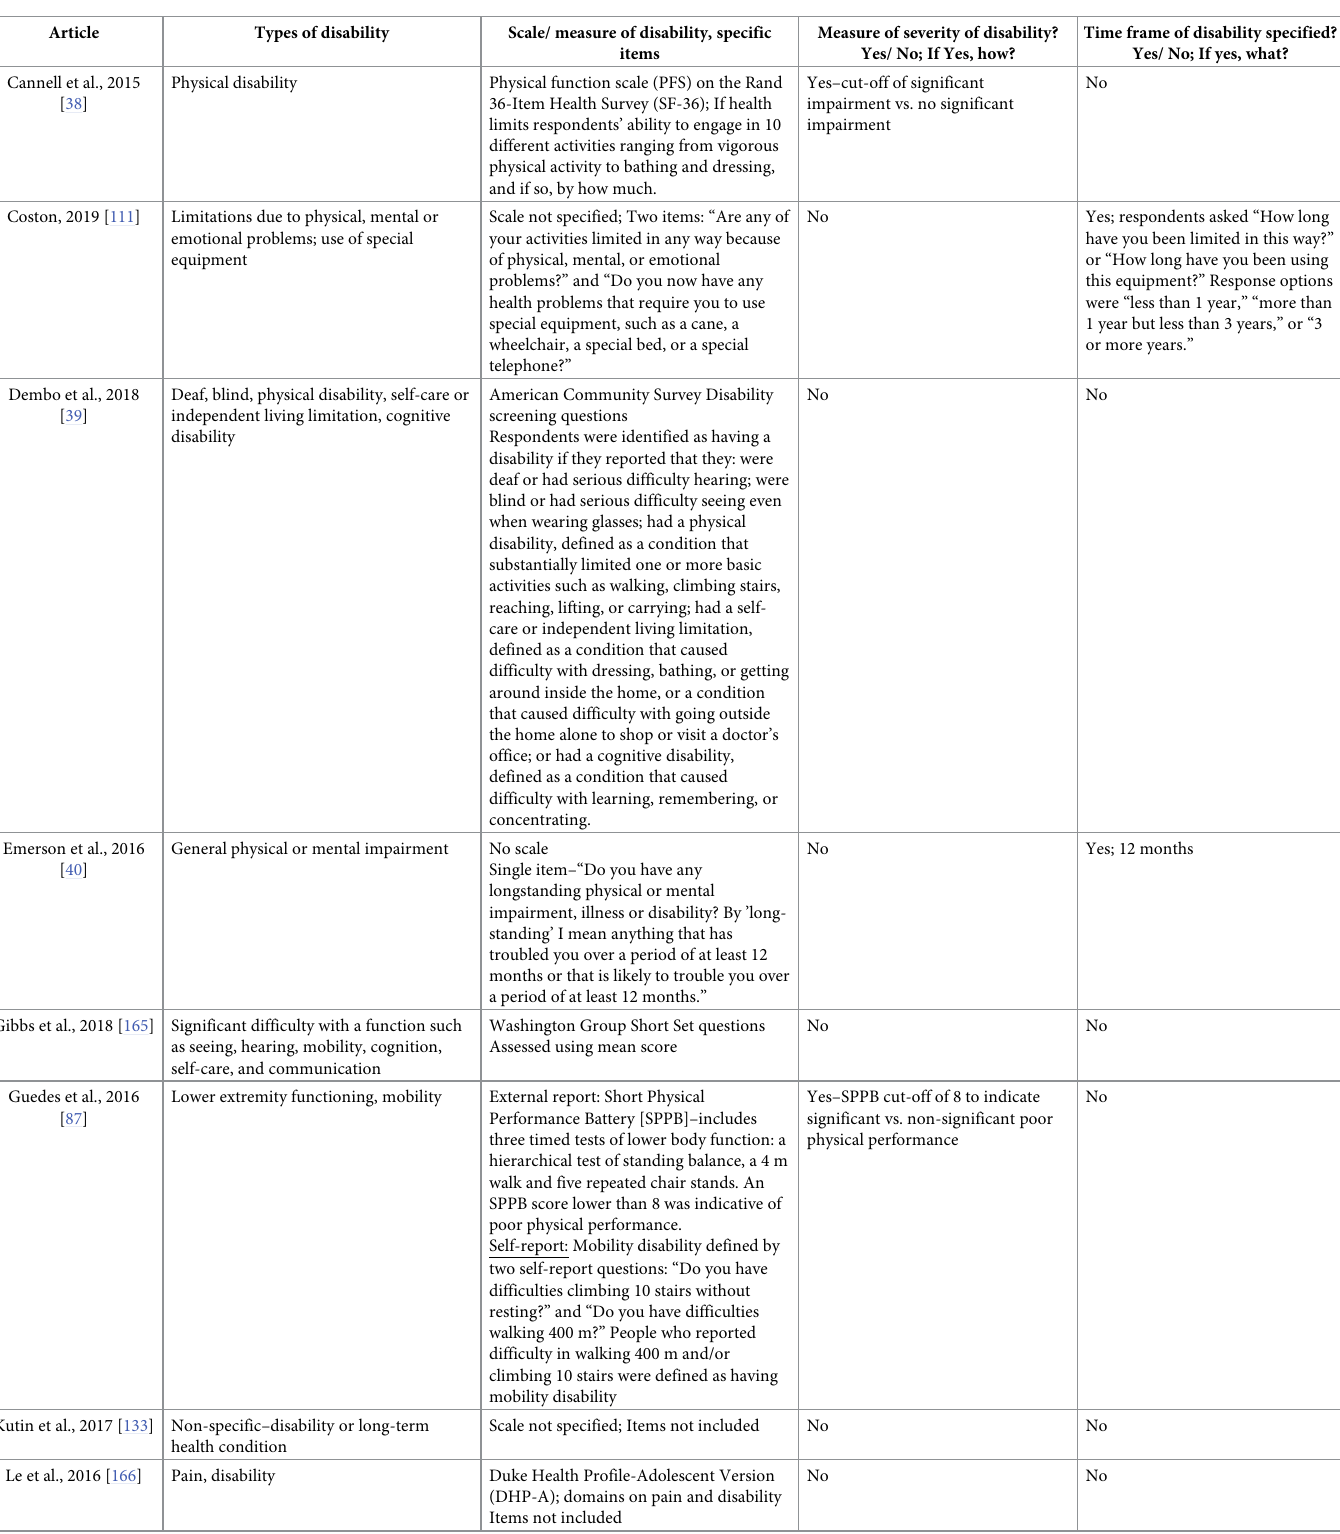
External report: Short Physical Performance Battery [SPPB]–includes three timed tests of lower body function: a hierarchical test of standing balance, a 4 m walk and five repeated chair stands. An SPPB score lower than 8 was indicative of poor physical performance. Self-report: Mobility disability defined by two self-report questions: “Do you have difficulties climbing 10 stairs without resting?” and “Do you have difficulties walking 400 m?” People who reported difficulty in walking 400 m and/or climbing 10 stairs were defined as